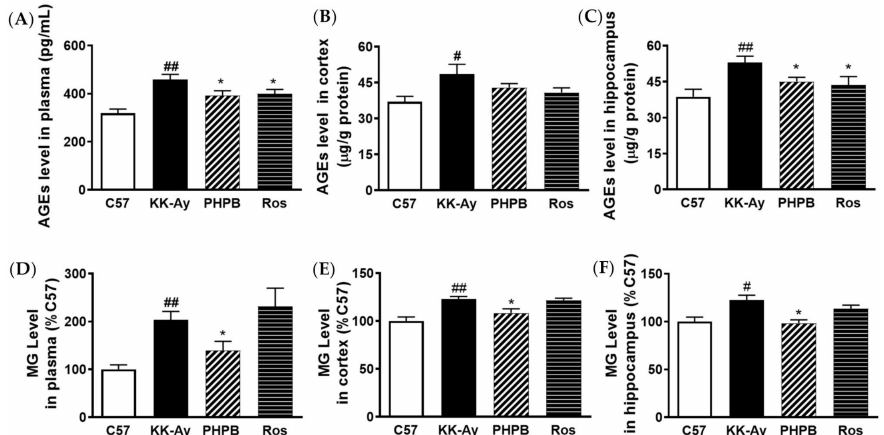
Figure 5. PHPB decreased the generation of AGEs or MG in the plasma and brain of KK-Ay mice. ( A – C ) Quantification of AGEs levels in plasma, cortex, and hippocampus by ELISA kits, and its levels were normalized to total protein concentration in the tissue samples of mice treated by PHPB (150 mg/kg) or rosiglitazone (Ros, 5 mg/kg) for two months, n = 8 for each group. ( D – F ) The MG contents (fold increase vs. that of C57 mice) of plasma, cortex, and hippocampus were measured by using the HPLC-UV method, n = 7–10 for each group. The data are presented as means ± SEM.